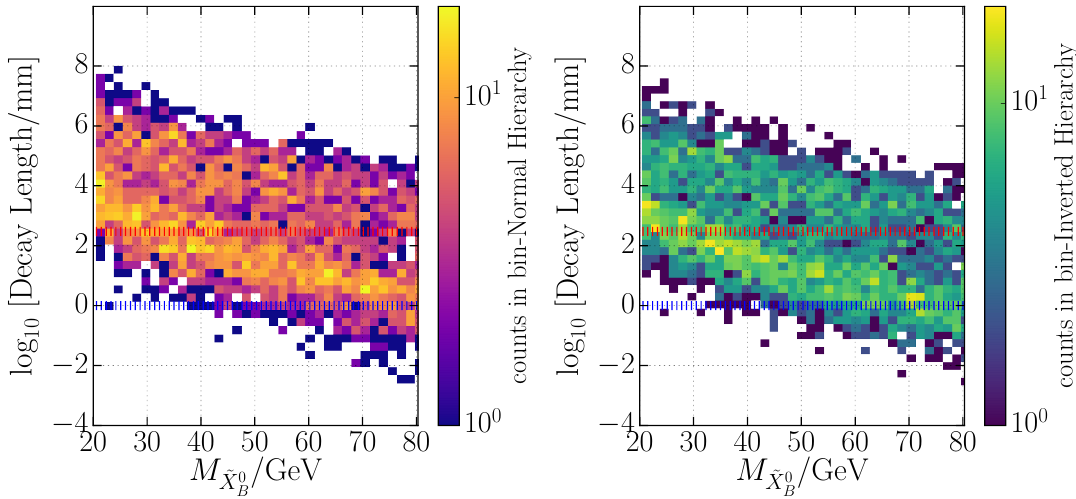
Figure 12. Bino neutralino LSP RPV decay lengths, summed over all three channels, for Bino masses lighter than the W (cid:6) and, hence, which can only decay through an o(cid:11)-shell boson. The results are in millimeters, for the normal and inverted hierarchies. The average decay length L = c (cid:2) 1 (cid:0) increases for smaller values of M ~ . We have chosen (cid:18) 23 = 0 : 597 for the normal neutrino hierarchy X 0 B and (cid:18) 23 = 0 : 529 for the inverted hierarchy to display the results. At and below the blue dashed line ( c(cid:28) = 1 mm), the decays are considered prompt. The red dashed line ( c(cid:28) = 30 cm) denotes the largest decay lengths that may be measured via displaced